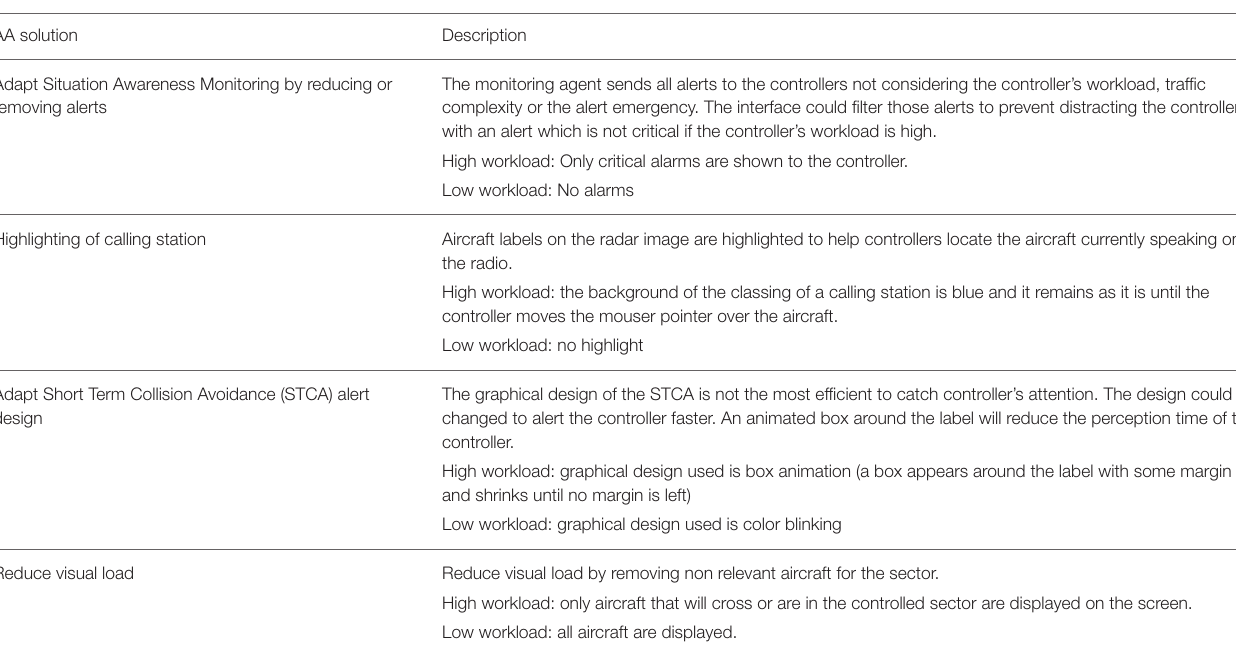
TABLE 1 | Description of the AA solutions developed at